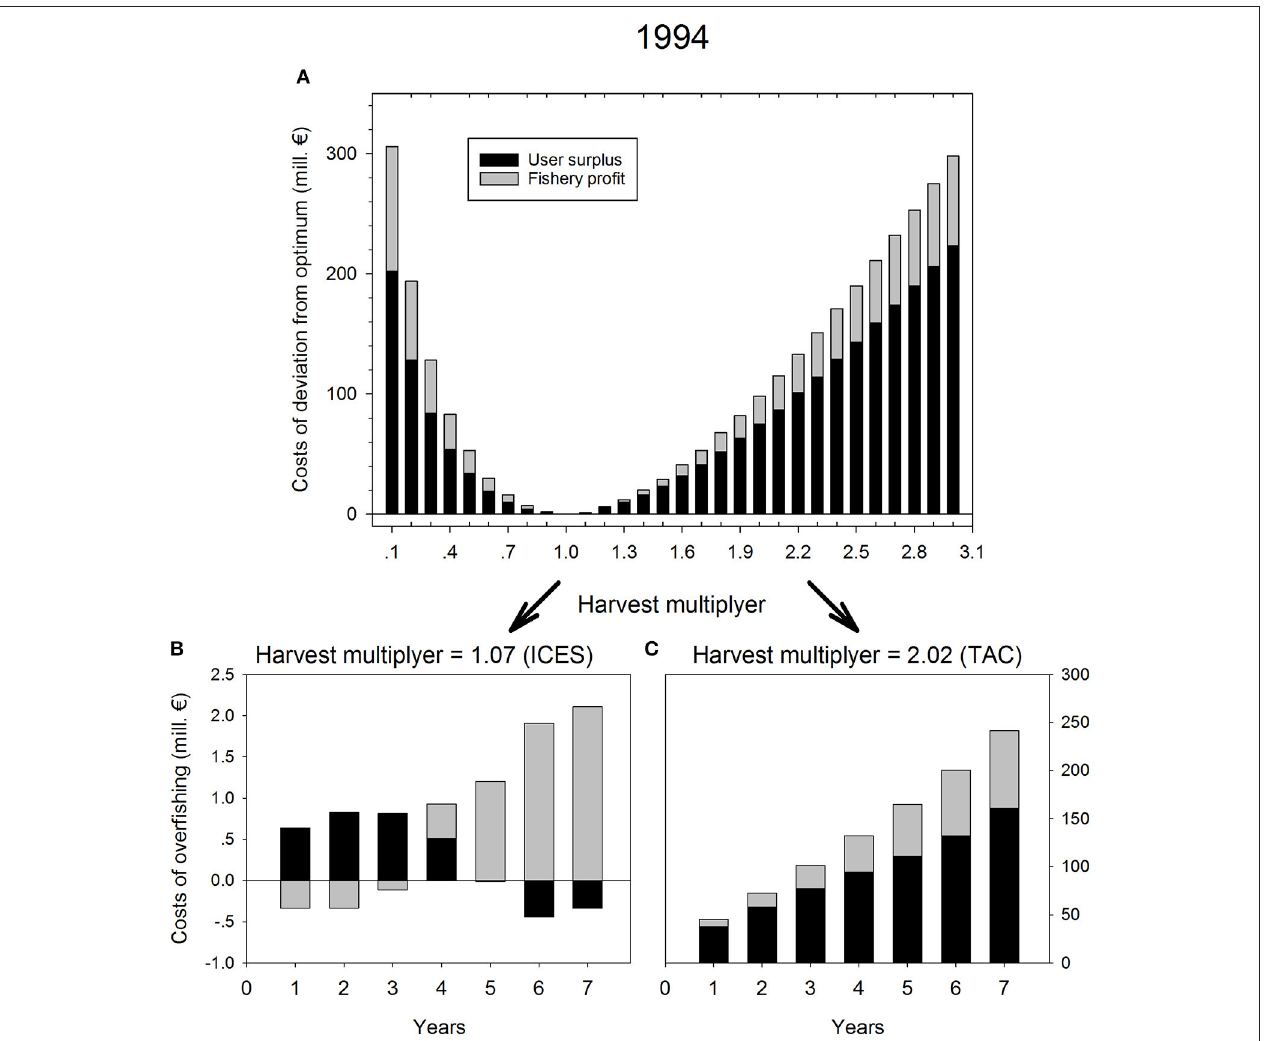
FIGURE 3 | Economic costs of over- or under-fishing for the year 1994. Costs for the fishery in terms of foregone fishery profits as well as for the consumers and fish processing industry (user surplus). Costs depend on the degree of deviation from ecological-economic optimal harvest ( A ; harvest multiplier of 1.0 = optimal) as well as on duration of sub-optimal management (B,C) . Costs are summed over a simulated 10 years